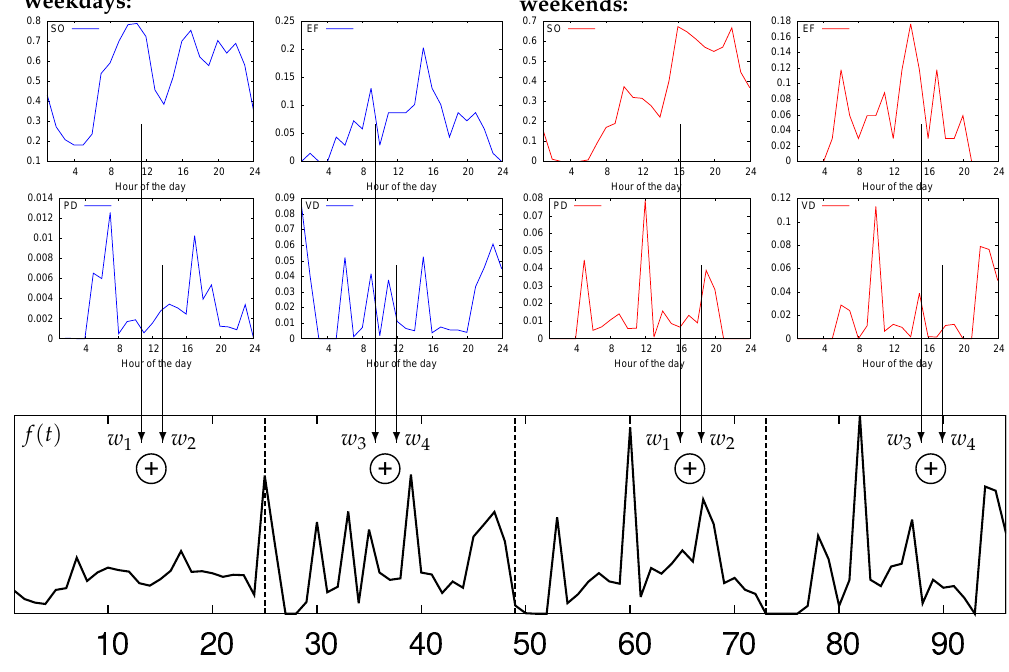
Figure 4. Feature function f ( t ) : calculation example for a typical parking sensor. The feature vector x i = [ x i 1 , . . . , x iK ] T for sensor i is obtained as x it ← f ( t ) for t = 1, . . . , K